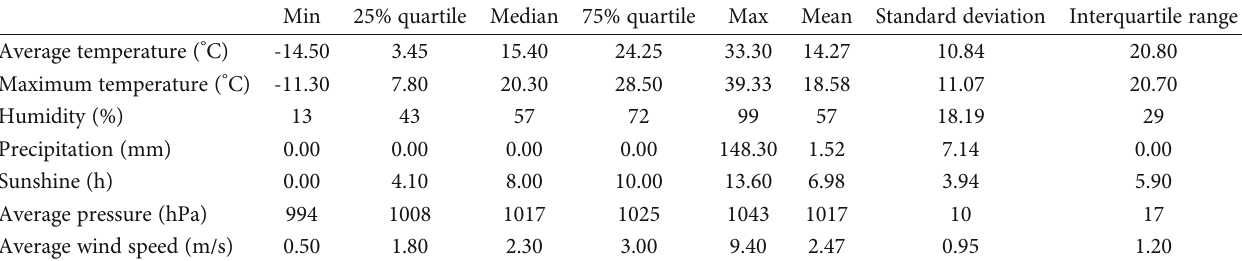
Table 3: Meteorological factors in Binhai New Area during 2014 to